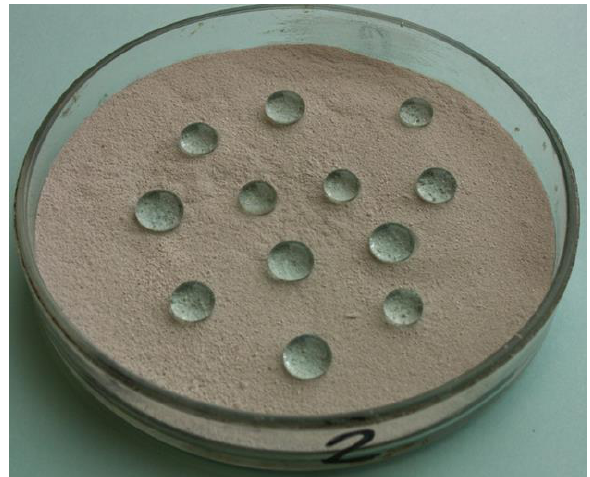
Figure 4. Petri dish containing modified gypsum powder, with drops of water applied to the surface.